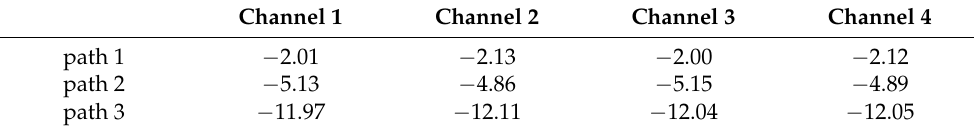
Table 3. Measured value of path loss (unit: